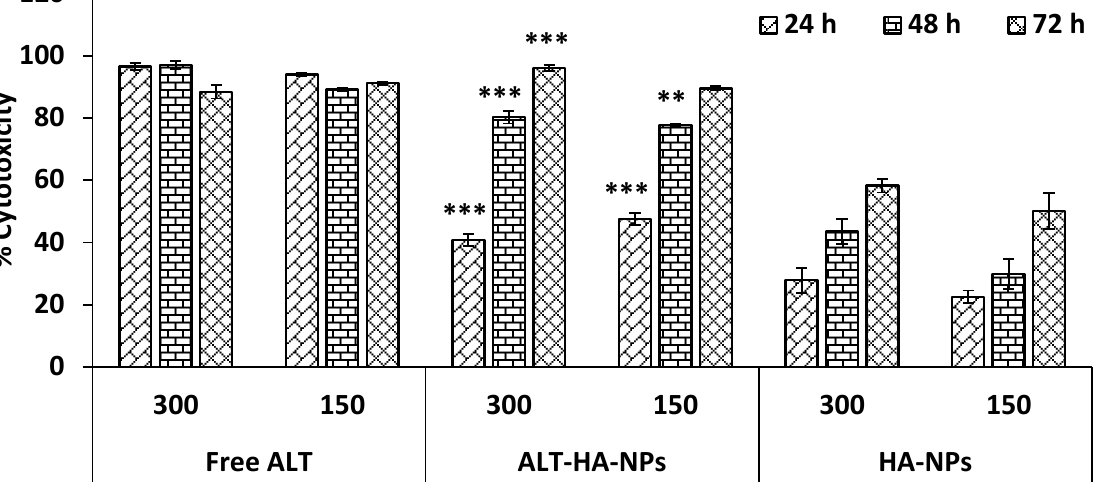
Figure 4. The outcome of ALT-HA-NPs, free ALT, and HA-NPs on the JURKAT cell line (n = 3, mean ± SD) is time- and dose-dependent. *** p < 0.001 and ** p < 0.01 denotes a significant difference between free ALT and ALT-HA-NPs.